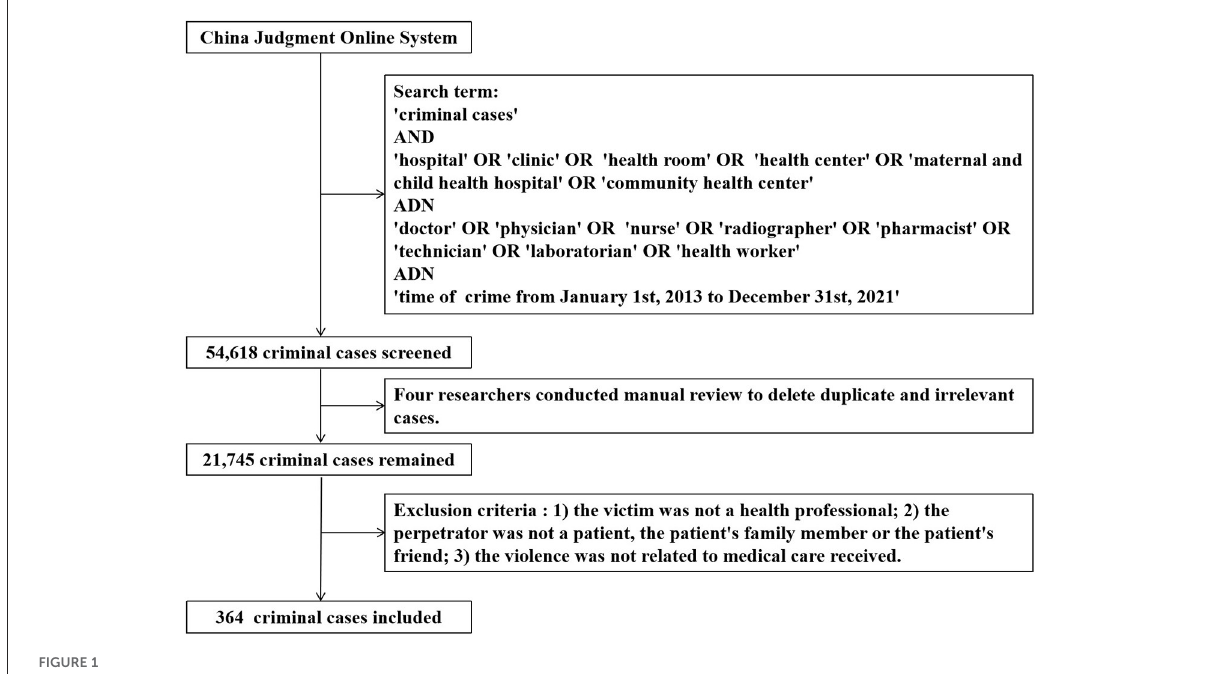
FIGURE1 Flow chart of judgment document extraction.